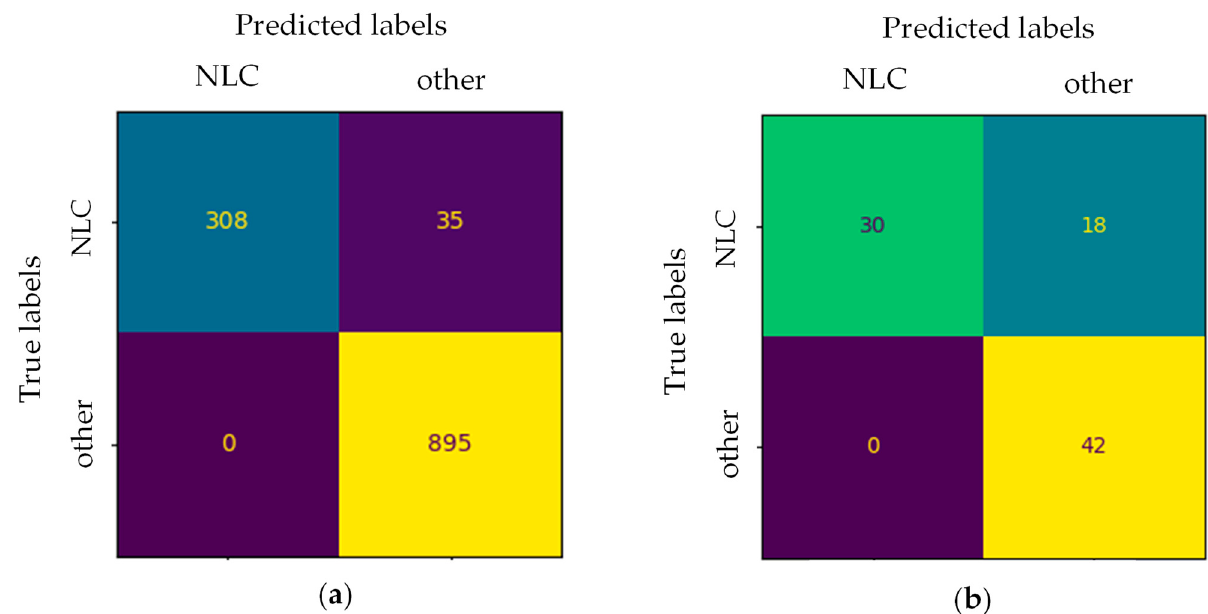
Figure 6. Confusion matrix for the SqueezeNet model ( a ), confusion matrix for test dataset from the